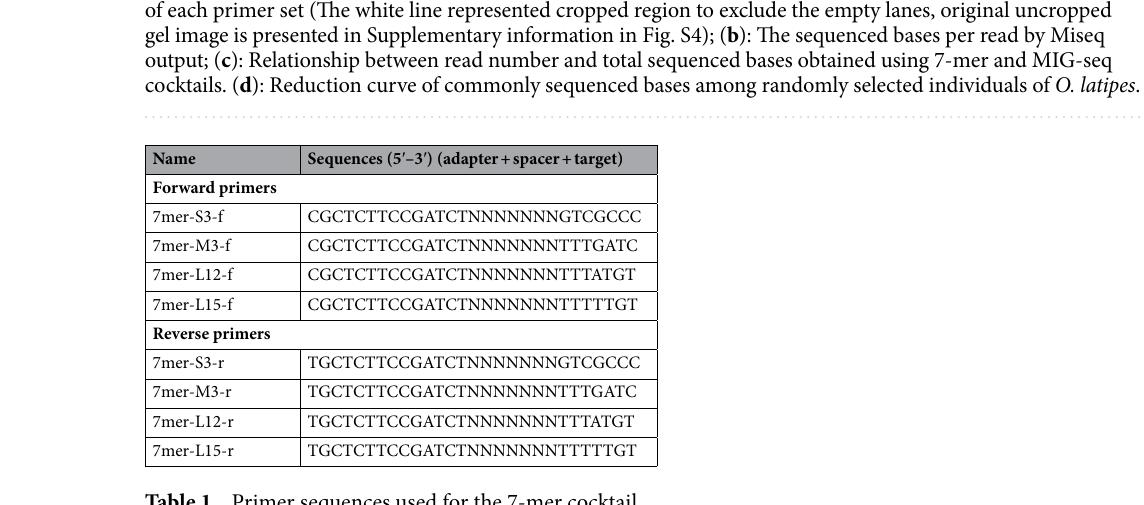
Table 1. Primer sequences used for the 7-mer